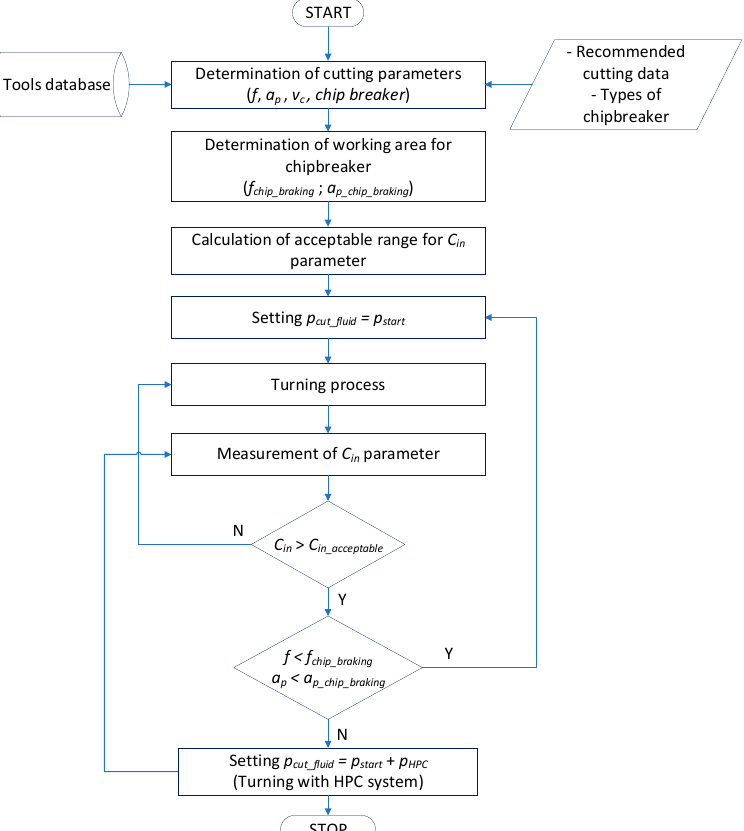
Figure 5. General algorithm for setting the cutting parameters and coolant method because of the chip geometry.